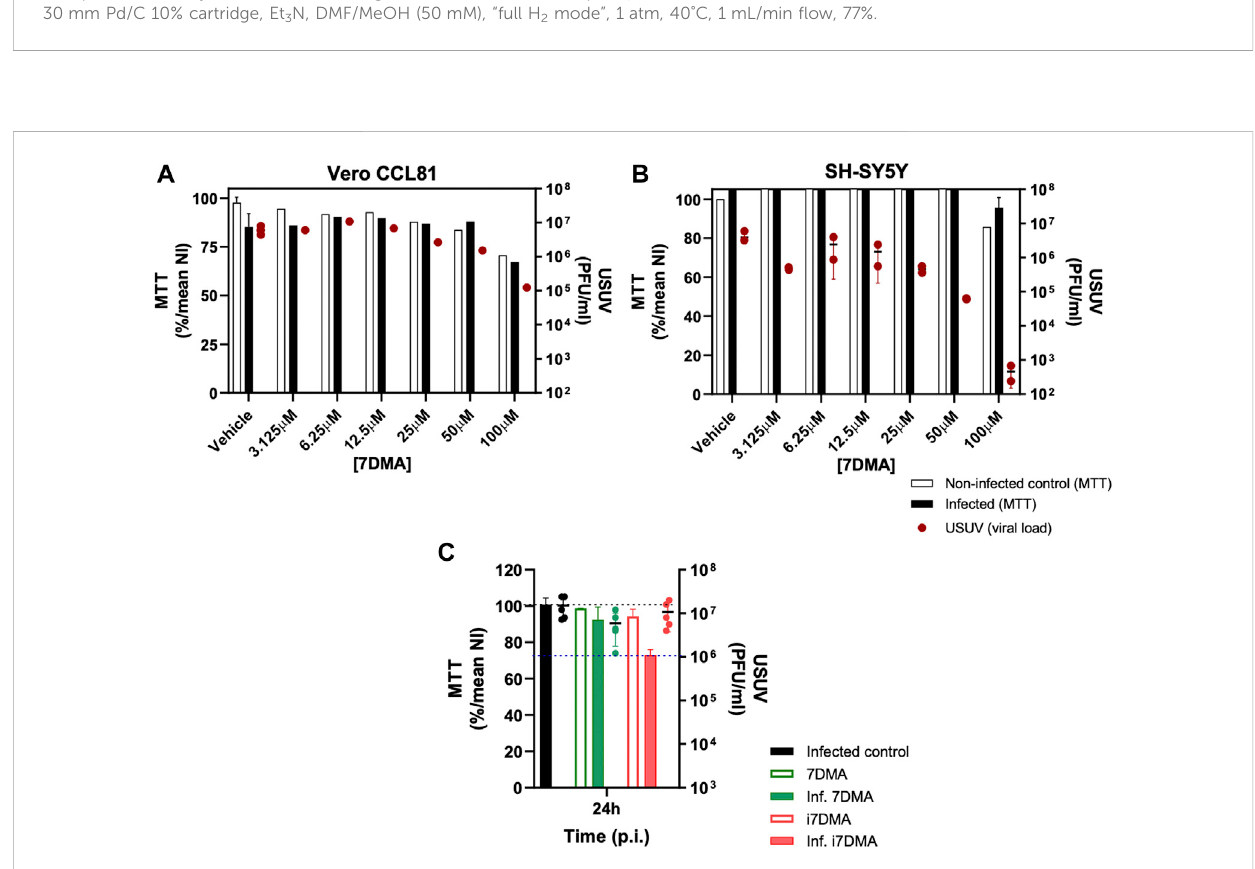
FIGURE 4 Antiviral effect of 7DMA ( 2 ) and i7DMA ( 13 ) against USUV and cell viability assessments. (A – B) Dose-dependent inhibition of USUV replication by 7DMA. Vero CCL81 or SH-SY5Y cells were infected and treated with vehicle or 7DMA in concentrations ranging from 3.1 to 100 µM. Cell culture supernatant was collected at 48 h post-infection for the assessment of infectious viral load. Cell viability was assessed using the MTT assay. The left Y axis represent the percentage of viable cells relative to non-infected vehicle-treated controls (NI, 100%) (white bars) and infected and treated cells (black bars). The right Y axis represent viral load results expressed in plaque-forming units (PFU/ml) of culture supernatant, presented as red circles. (C) Cytotoxic effect of i7DMA in infected cells. Vero CCL81 cells were infected with USUV and treated with vehicle (black bar), 7DMA (green bar) or i7DMA (orange bar) at the concentration of 10 µM; non-infected Vero CCL81 cells were treated with 7DMA (green outlined bar) andi7DMA(orangeoutlinedbar)atthesameconcentration.Cellculturesupernatantwascollectedat24 hpost-infectionfortheassessmentofinfectious viral load (green and orange circles for 7DMA and i7DMA, respectively). Cell viability was assessed as described above. Data are representative of two or more independent experiments and indicate mean ±SE (n = 2 to